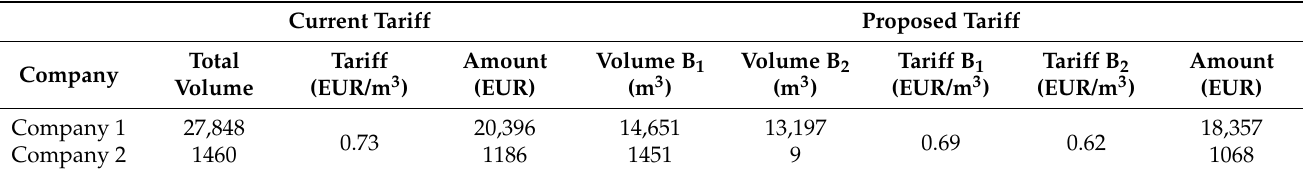
Table 8. Current situation and proposal for consumptions